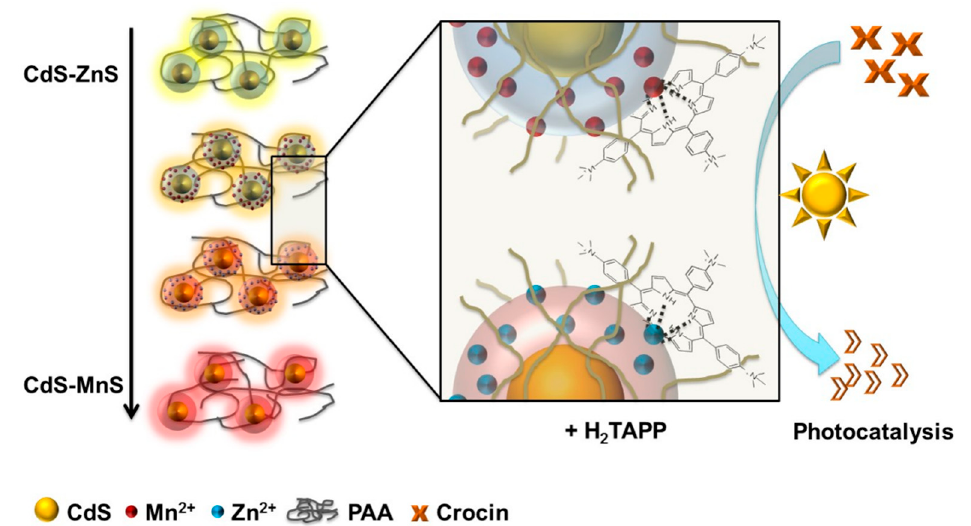
Figure 1. Scheme of catalytically active assemblies with tunable spectral properties: fluorescent color change in dependence on increasing manganese content in the shell and interaction of TAPP with the inorganic nanoparticles.